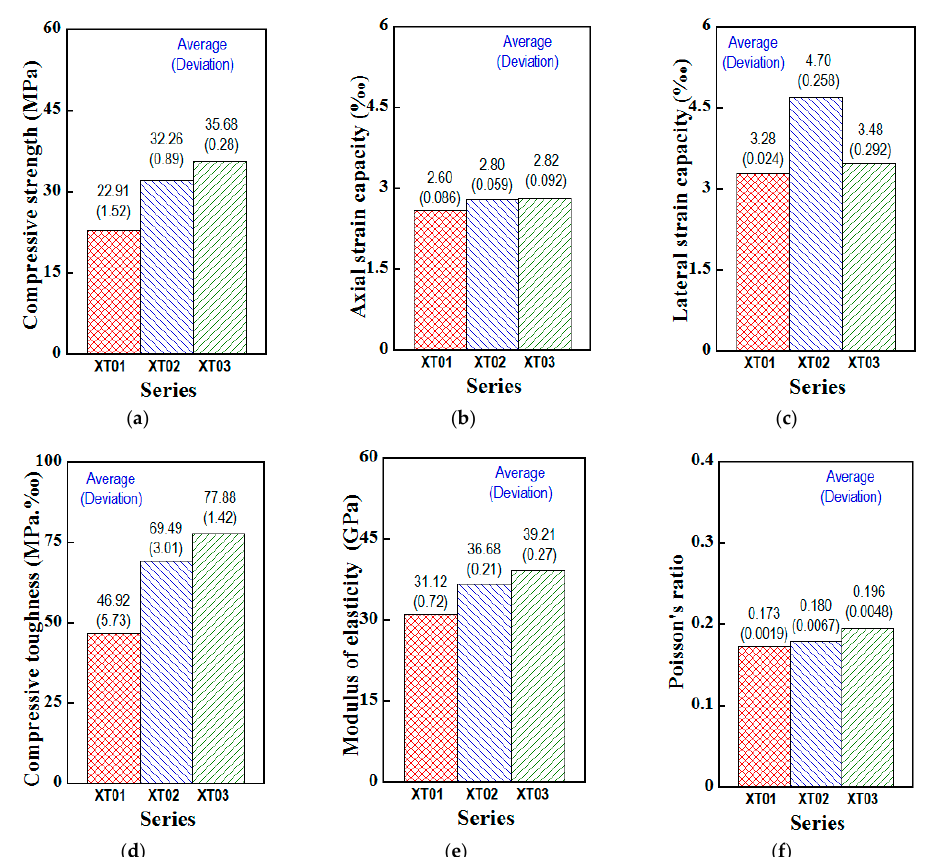
Figure 8. Comparison of compressive parameters at the 28-day age of three steel-slag concretes using